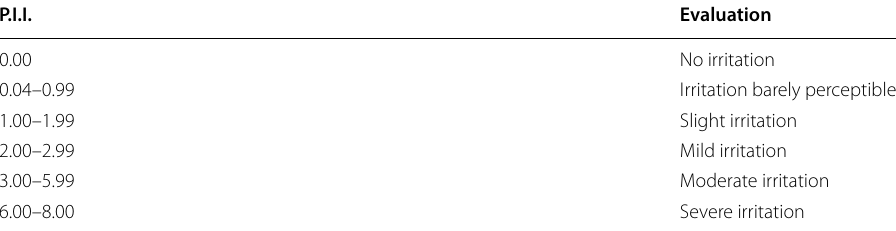
Table 2 Evaluation of primary irritation index